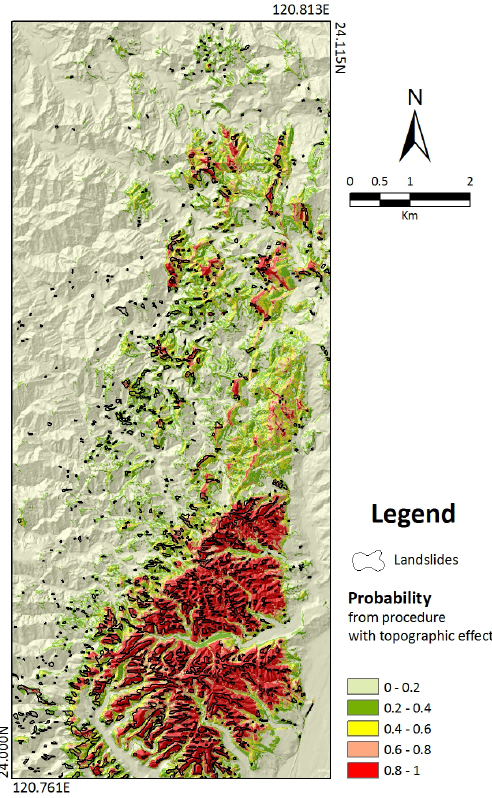
Fig. 11. Landslide susceptibility map based on logistic